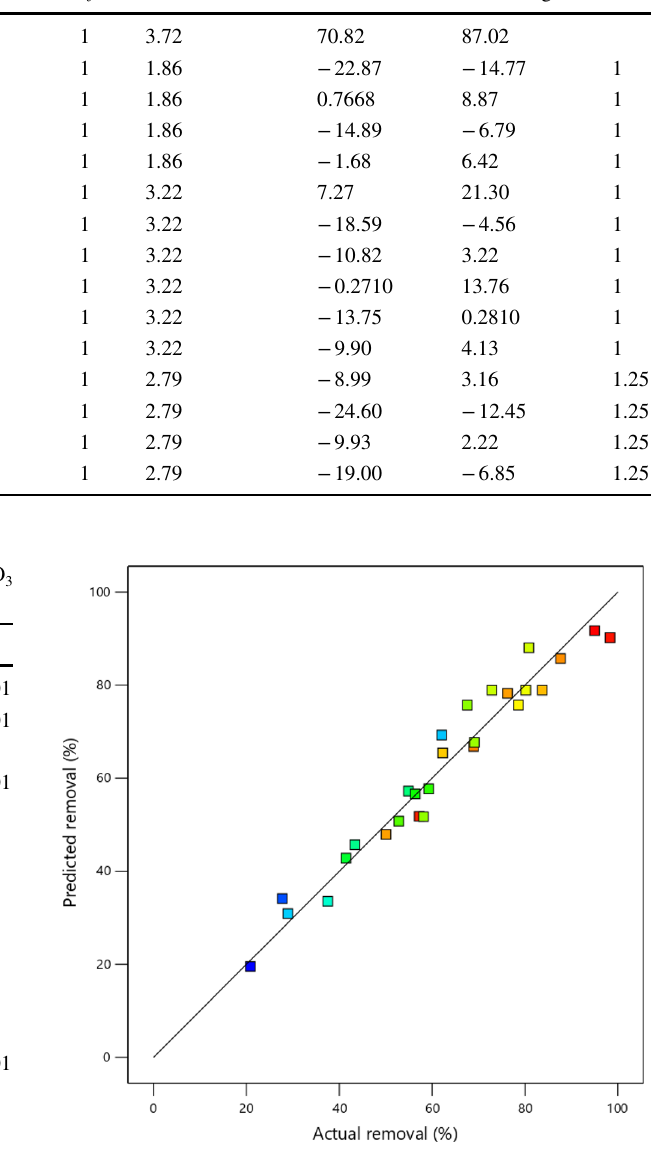
Fig. 5 Distribution of experimental versus predicted removal for RR-141 adsorption onto γ -Al 2 O 3